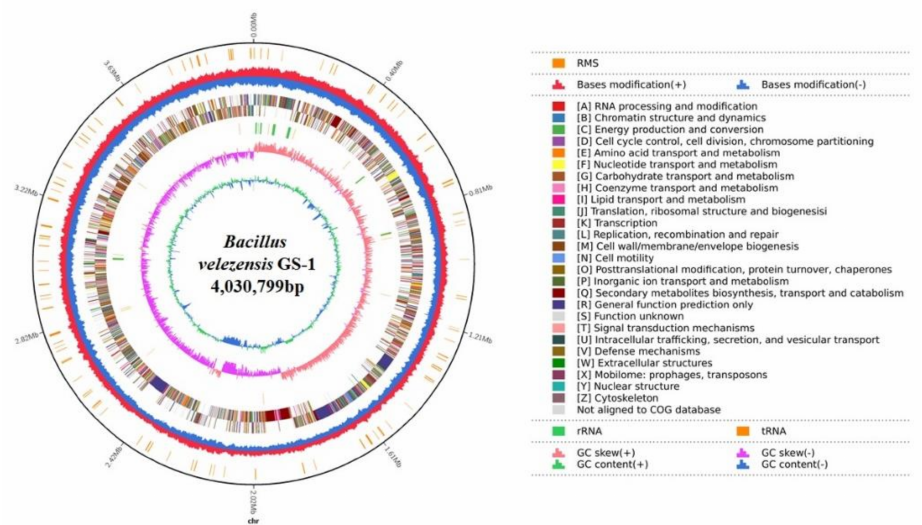
Figure 2. Circular genome map of B. velezensis GS-1. From the innermost to the outermost: ring 1 for GC content, ring 2 for GC skew, ring 3 for distribution of rRNAs (green) and tRNAs (brown), ring 4 for COG classifications of protein-coding genes on the forward strand and reverse strand, ring 5 for restriction modification system, and ring 6 for genome size (black line).